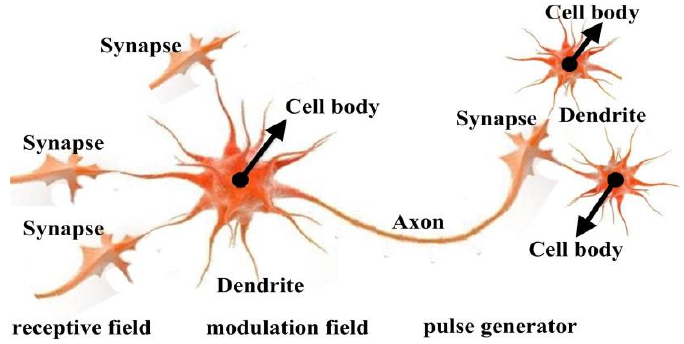
Figure 1. Structure of visual cortex neuron.